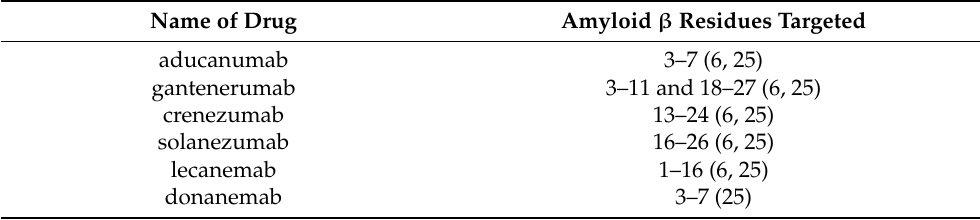
Table 9. Drugs in Clinical Trials and Residues